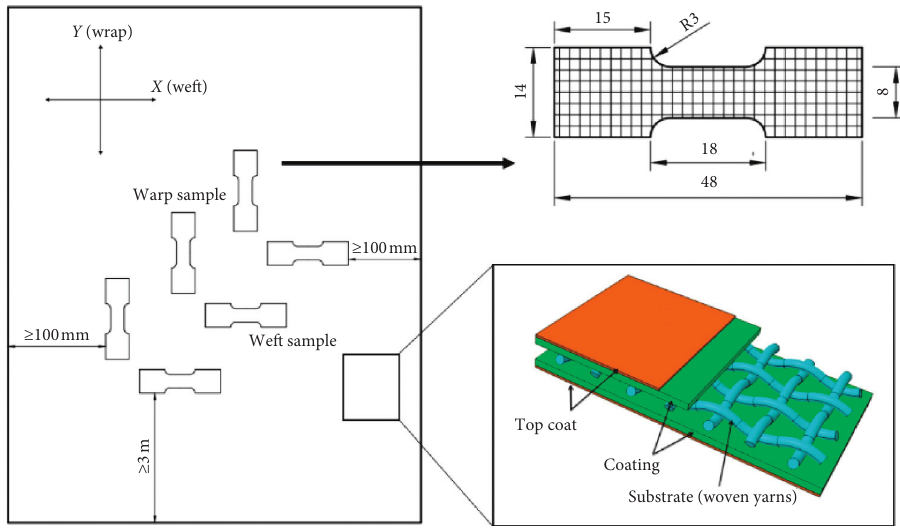
Figure 2: Diagram of cutting size and composition of the